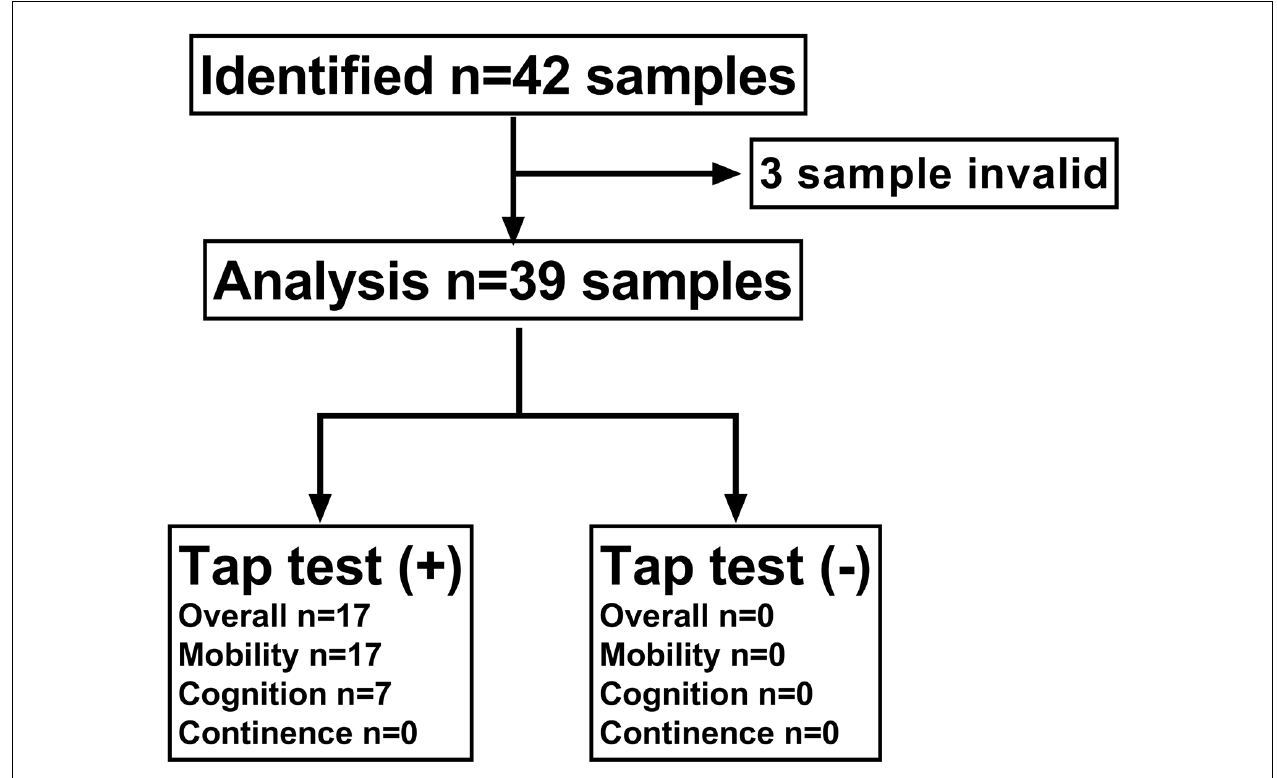
FIGURE 1 | Flow chart of participating patients. Thirty-nine patients with suspected idiopathic normal pressure hydrocephalus (iNPH) were included in the final predictive value analysis. Secondary samples that underwent a tap test (+) ( n = 17) or ( − ) ( n = 22) were included in the longitudinal analysis of biomarkers in lumbar cerebrospinal fluid